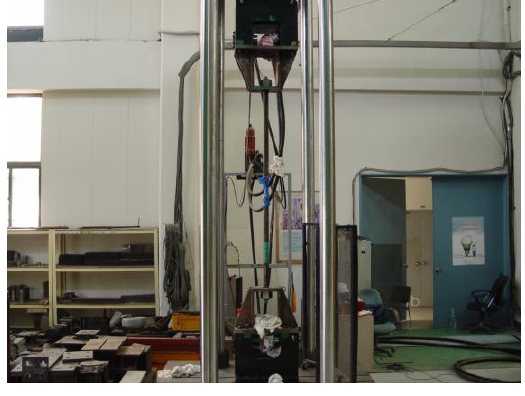
Figure 9. Tensile test set-up.